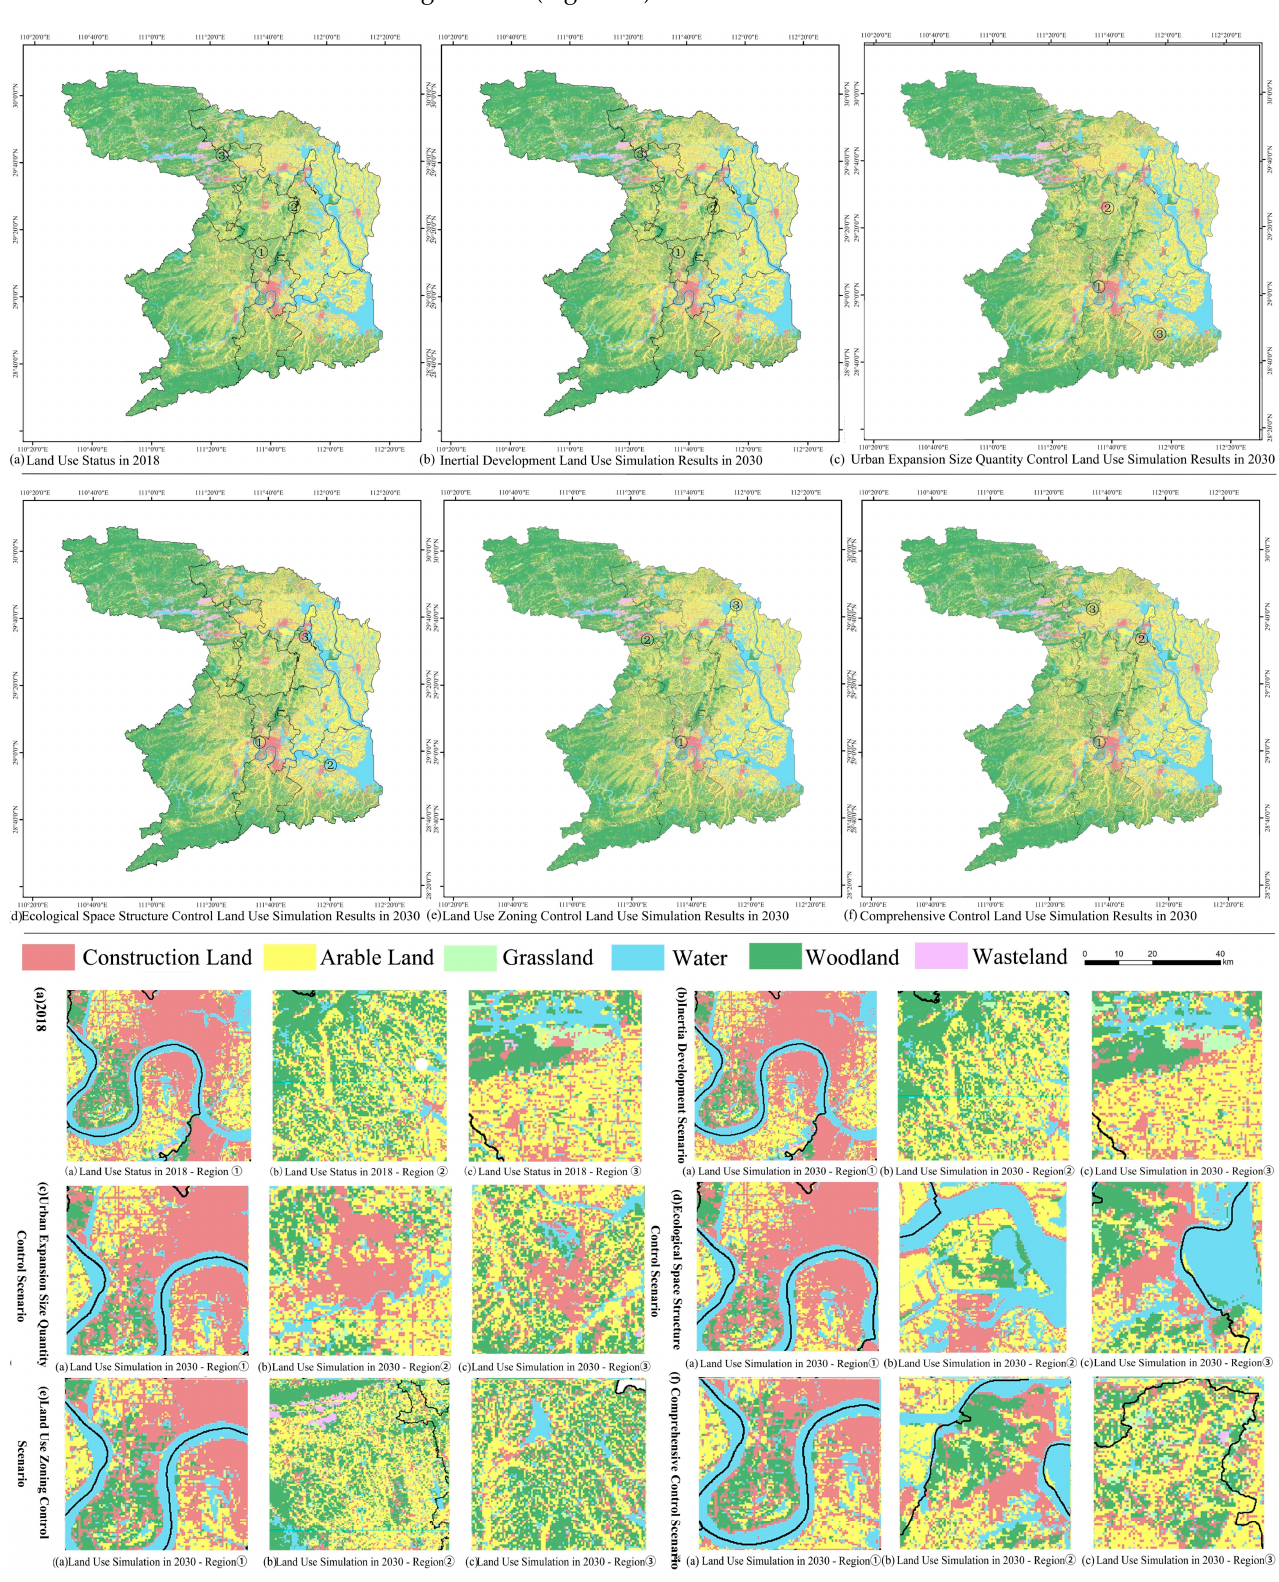
Figure 5. Comparison of the Land Use Status of Actual Changde in 2018 and the Results of the Modeling of Scenarios.